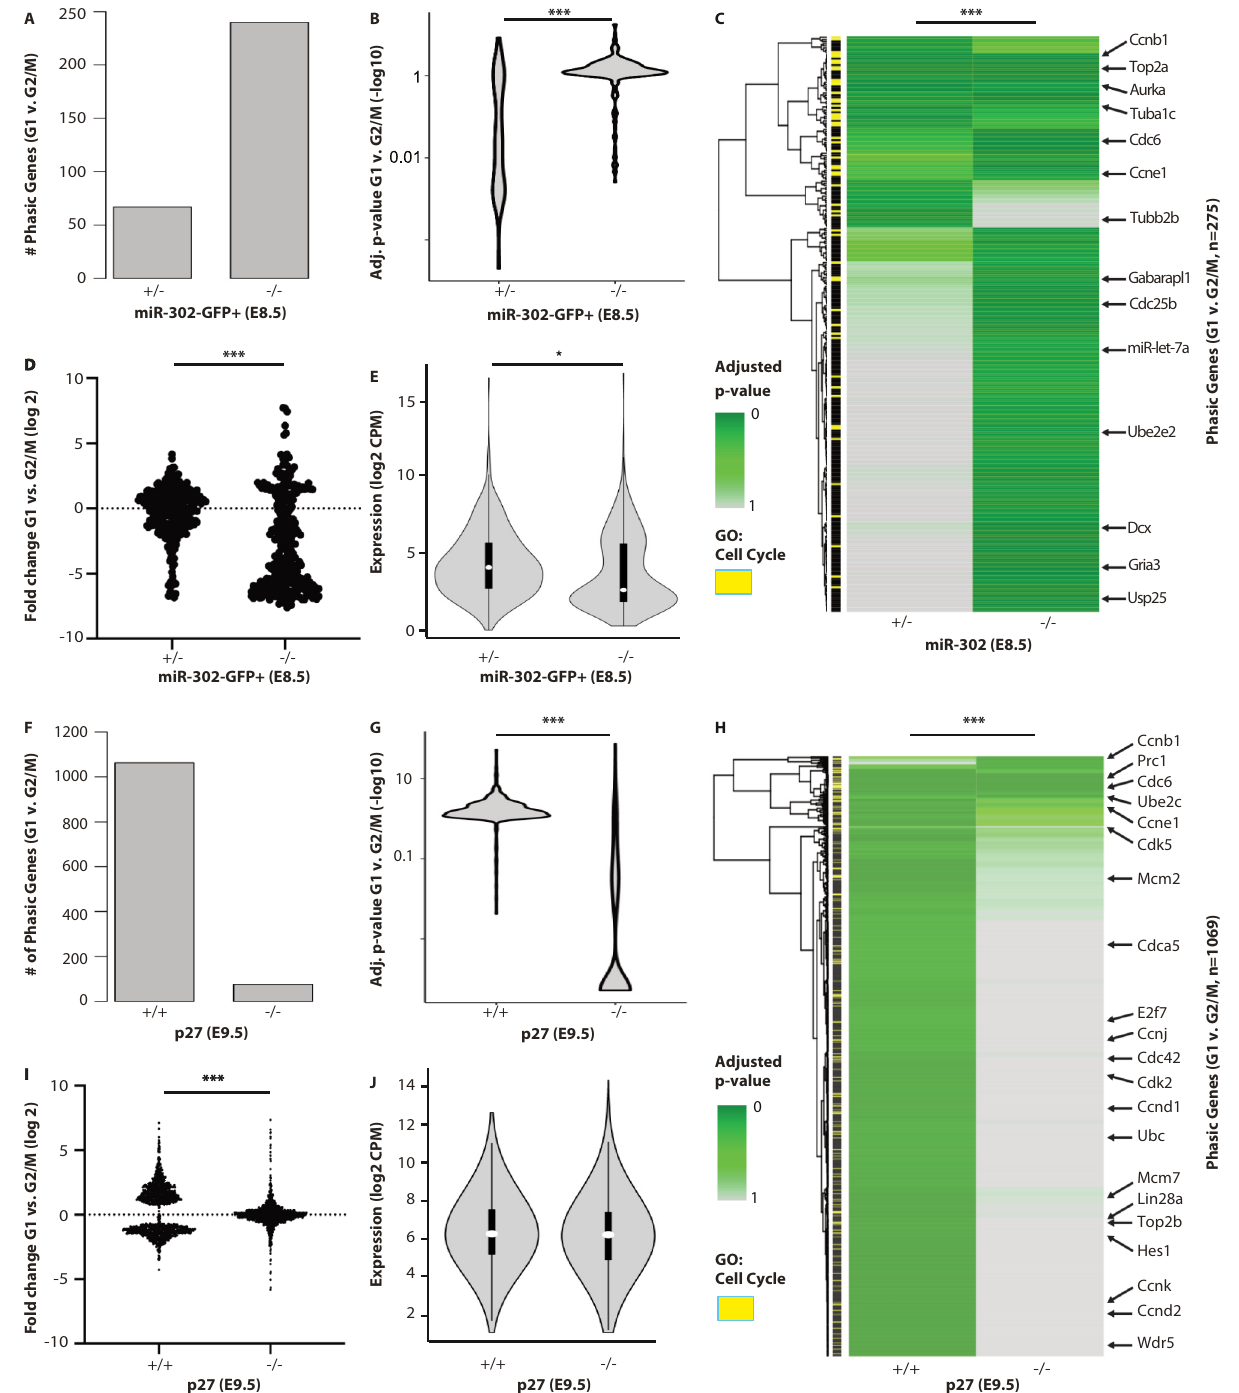
Fig. 2 miR-302 suppresses while p27 promotes the onset of phasic expression. A The number of genes showing differential expression between G1 and G2/M (BH adj. P < 0.1) in mir-302 -GFP + sorted populations from control and mir-302 − / − E8.5 embryos ( n = 3 biologically independent embryos). B The distribution of adjusted P values of the union of all genes identi fi ed in ( F ) (Wilcoxon Rank Test, two-sided, *** P < 0.001). C A heat map of P values for all genes shown in ( B ) (Wilcoxon Rank Test, two-sided, *** P < 0.001). D The distribution of fold-change values for all genes shown in ( C ) (*** P < 0.001, two- tailed t test). E The distribution of log2 counts per million for all gene shown in ( G ) ( P < 0.05, two-tailed t test, n = 284 genes). White dot, median. Box edges, 25th and 75th quartiles. Whiskers, 1.5× the IQR of the box edge. F – H Same as ( A – E ), except comparing p27 control to knockouts ( n = 3 biologically independent embryos). I *** P < 0.001, two-tailed t test ( J ) no signi fi cant change, P > 0.5, two-tailed t test, n = 1069 genes. Differential expression was evaluated with a Wald Chi-squared test ( A – C , F – H